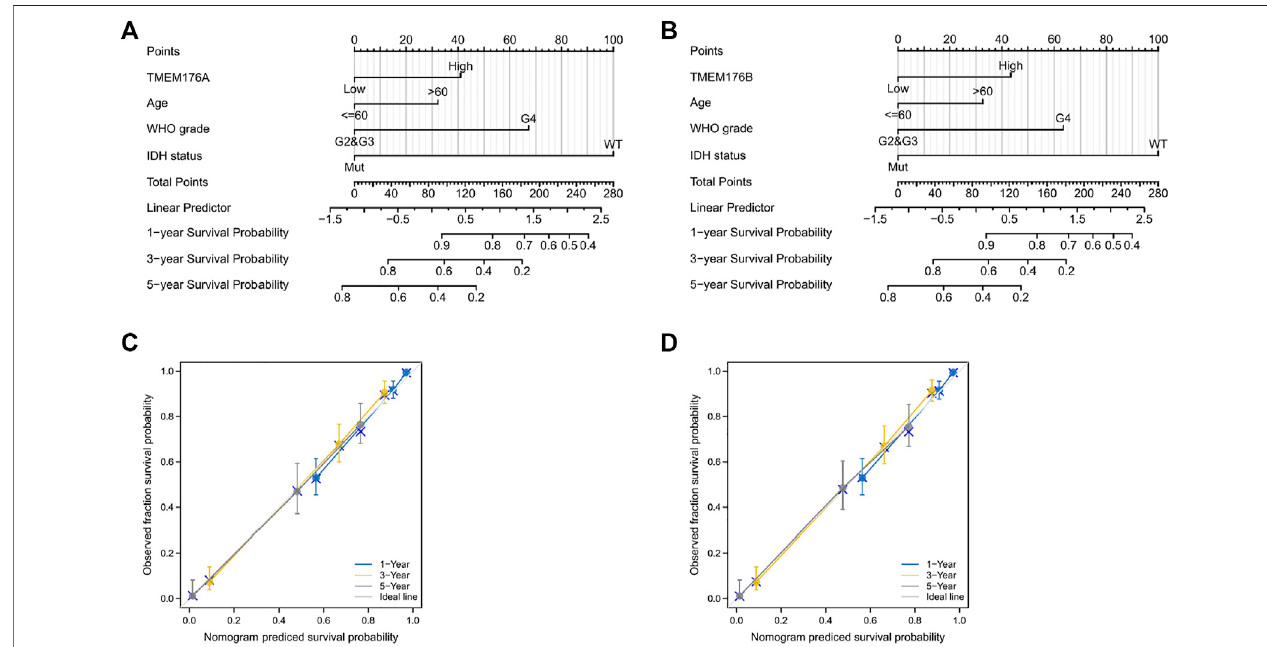
FIGURE 5 | MS4A-related prognostic nomograms. (A,B) Nomograms for 1-, 3-, and 5-year survival; (C,D) calibration curve for MS4As. The abscissa is the probability of nomogram-predicted OS, and the ordinate is the observed OS.